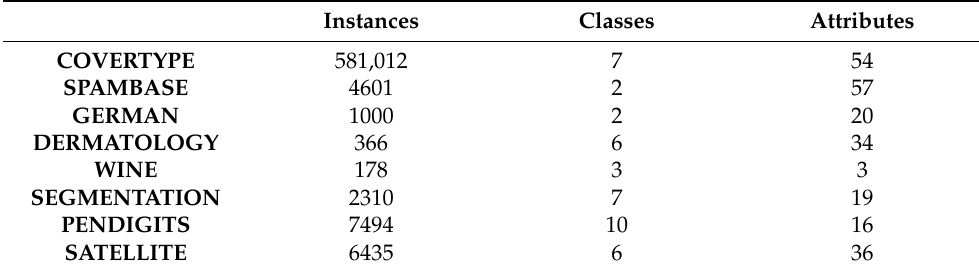
Table 2. Details of